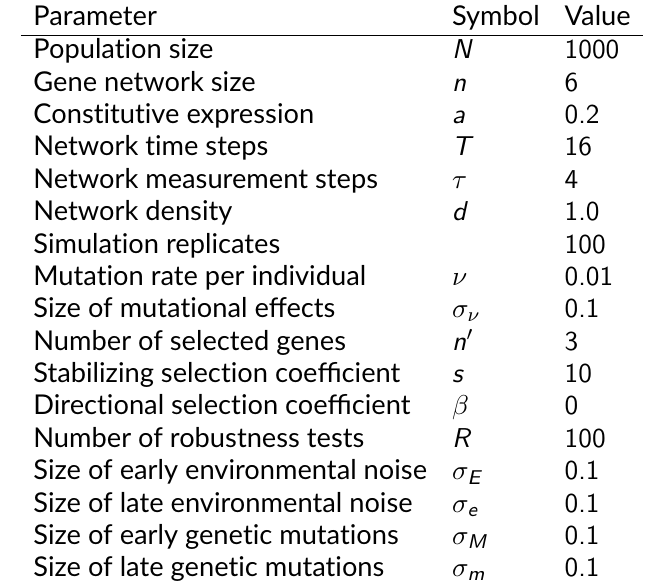
Table 2 – Default parameter values in the evolutionary